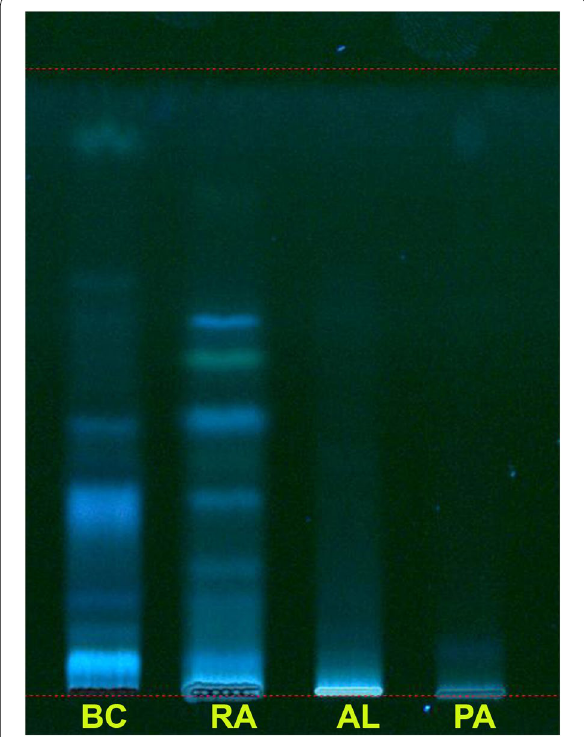
Fig. 1 Comparative HPTLC profile of selected source plants of Pashanabheda at 366